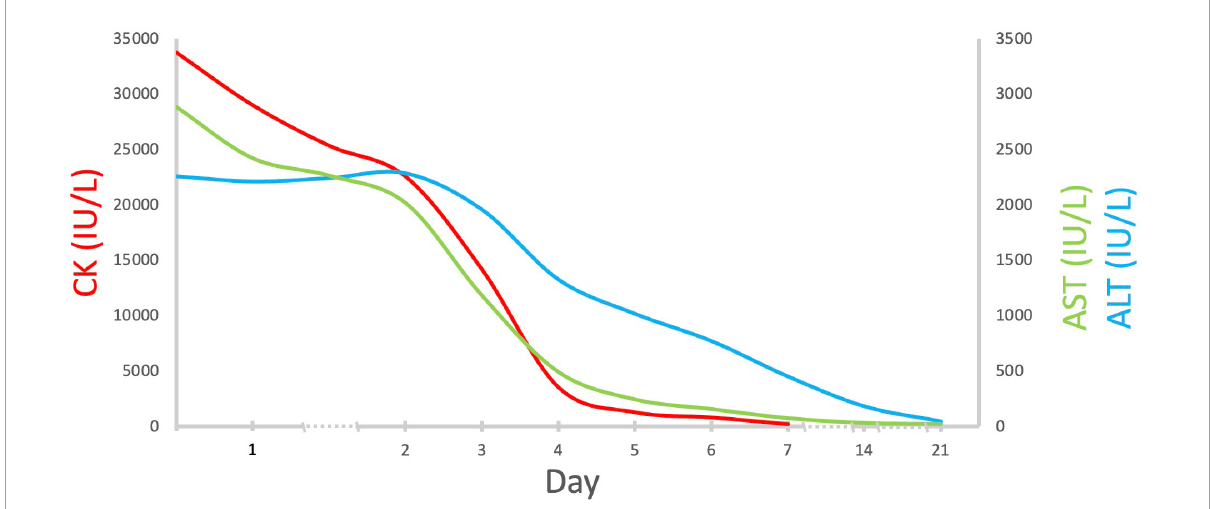
FIGURE2 Serial changes in serum CK, AST, and ALT levels. Abbreviations: CK, creatine kinase; AST, aspartate aminotransferase; ALT, aspartate aminotransferase.